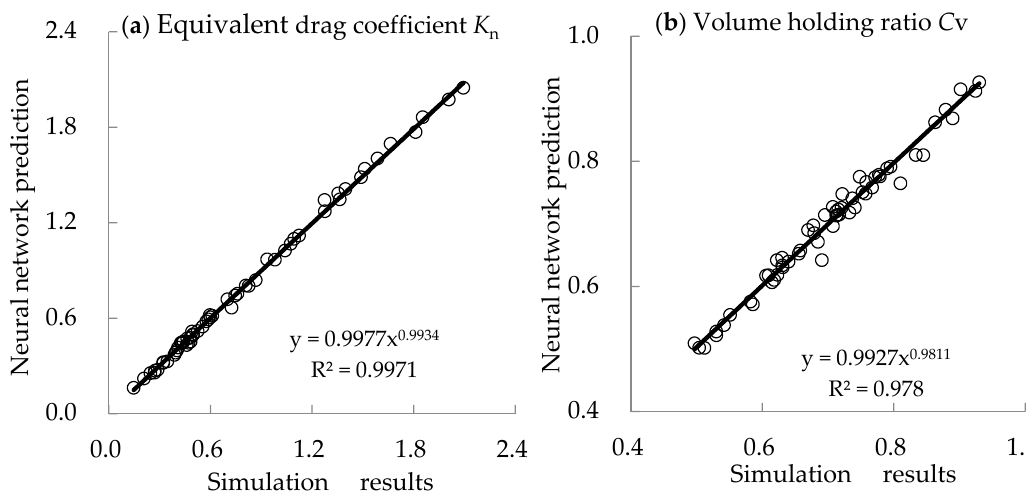
Figure 17. Relationships between neural network prediction and simulated results. ( a ) Equivalent drag